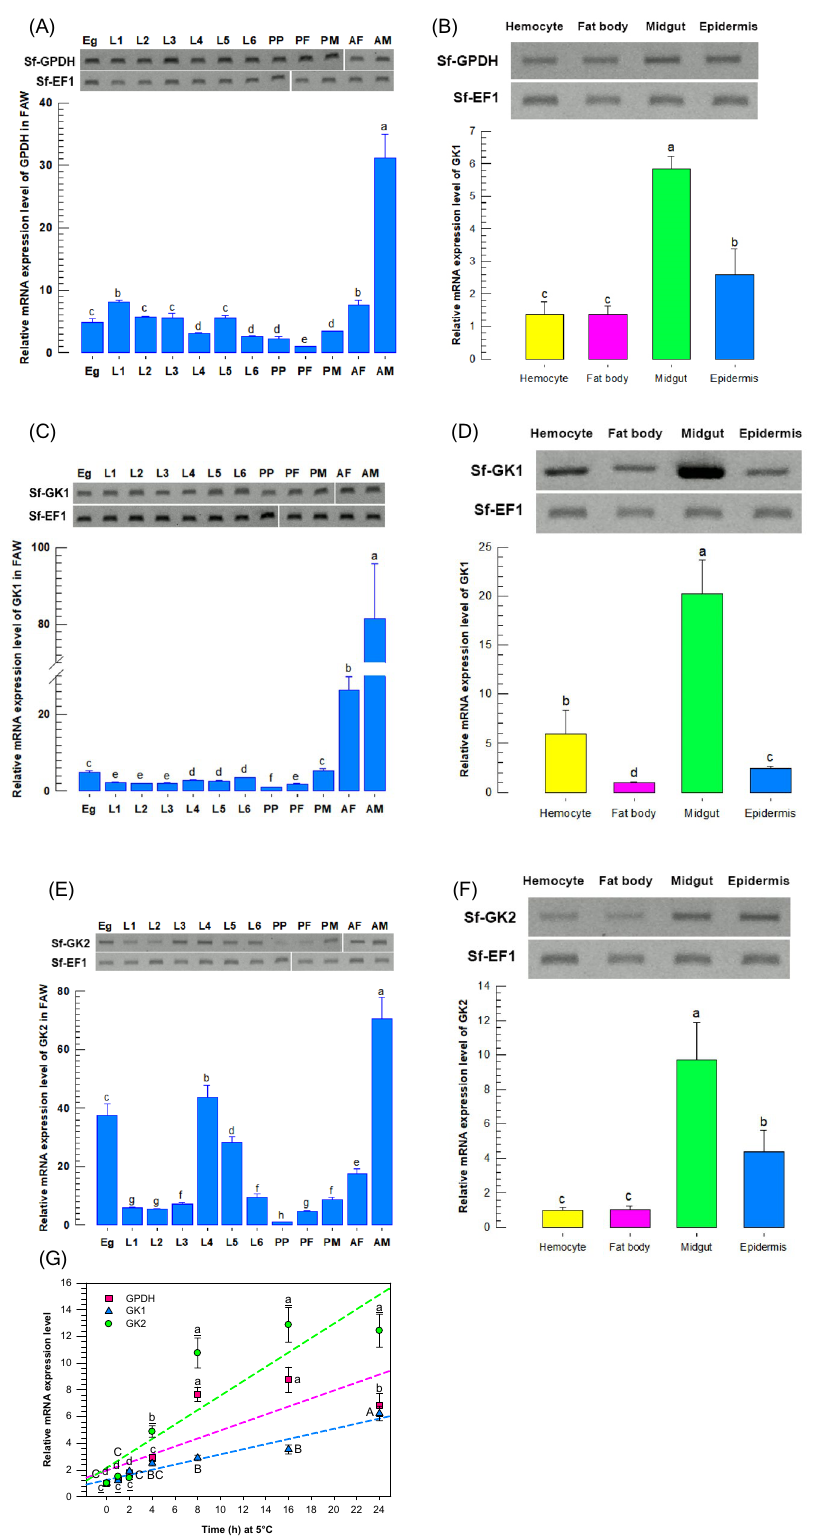
Figure 6. Expression analysis of glycerol biosynthesis genes from Spodoptera frugiperda . RT-PCR analysis of Sf-GPDH, Sf-GK1, and Sf-GK2 in different developmental stages ( A , C , and E , respectively) and tissues ( B , D , and F , respectively). The gels in ( A , C , and E ) were cropped from various gels and were cleared with vertical white space. The full-length gels are included in Supplementary Information (Fig. S2). EF1 was used to validate cDNA integrity. Different developmental stages included Egg (‘Eg’), larval instars ( ʻ L1–L6 ʼ ), pre-pupa (‘PP’), pupa of female ( ʻ PF ʼ ), pupa of male (‘PM’), adult of female ( ʻ AF ʼ ) and adult of male (‘AM’). Different tissues included hemocyte, fat body, midgut, and epidermis. ( G ) RT-PCR analysis of Sf-GPDH, Sf-GK1 and Sf-GK2 expression at low temperature (5 °C) at different exposure time (h). Agarose gel (1%) was used for electrophoresis. Each treatment was replicated three times. Different letters above standard deviation bars indicate significant difference among means at Type I error = 0.05 (LSD